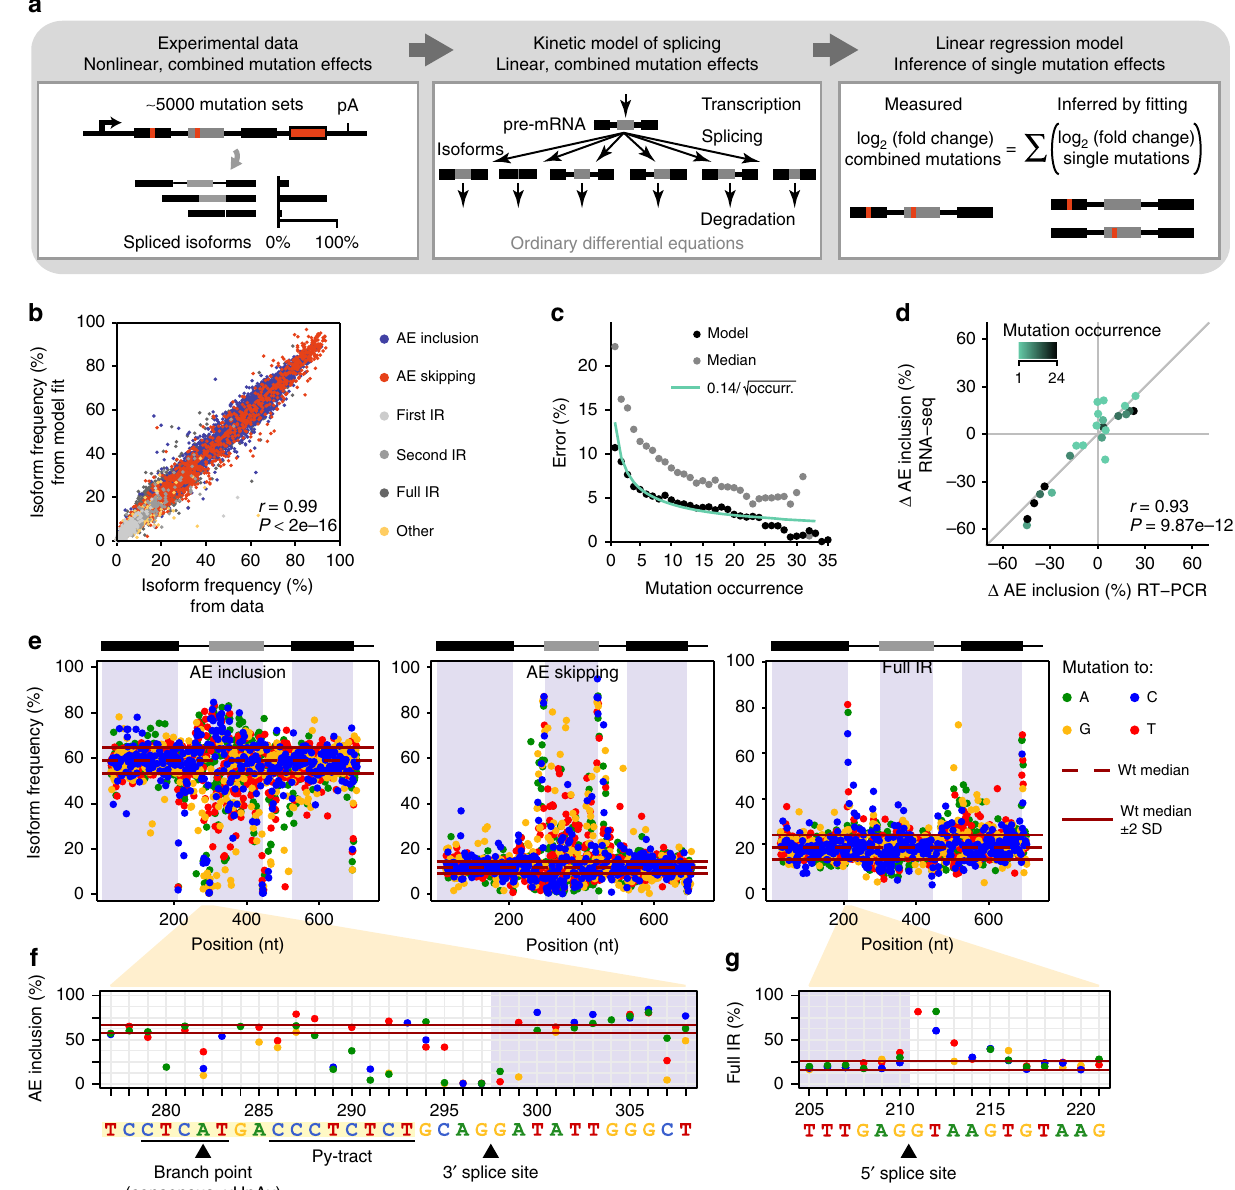
Fig. 2 A linear regression model determines more than 1900 single mutation effects. a Model-based inference of single mutation effects. Isoform quanti fi cations from RNA-seq for 5598 unique minigene variants, each harbouring multiple mutations, are used as input. A kinetic model of splicing reactions reveals that splice isoform ratios show linear mutation effects, irrespective of other mutations. A linear regression model is used to infer single mutation effects in a system of 5010 linear equations, one per mutated minigene variant. b Regression model describes experimental measurements with high correlation (Pearson correlation coef fi cient r = 0.99, P value <2e − 16). Scatterplot shows frequencies of distinct splice isoforms (see legend; separately shown in Supplementary Fig. 5a) for combined mutations calculated from fi tted model against one biological replicate (see Supplementary Note 2). c The model more accurately infers frequently occurring single mutation effects. Cross-validation by separately excluding single-mutation minigenes (and permutations of other minigenes containing this mutation). Inference is expressed as standard deviation of inference error in AE inclusion ( y -axis) and analysed for different permutations containing mutation at different frequencies ( x -axis). Inference power of model (black dots) matches theoretical expectation (green line) and outperforms median-based estimation (grey dots; see Supplementary Note 2). d Experimental validation of model- inferred single mutation effects. Semiquantitative RT-PCR measurements of AE inclusion (other isoforms in Supplementary Fig. 4b) for targeted single- mutation minigenes that were not used for model fi tting. Discrepancies between model and data appear if mutation infrequently occurs in the library (colour-coded). r , Pearson correlation coef fi cient and associated P value. e Model-inferred landscapes of 1747 single mutation effects on AE inclusion, AE skipping and full IR in HEK293T cells. Each mutation effect is indicated as a coloured dot (inserted nucleobase, see legend). Red lines indicate median (dashed) ± 2 standard deviations (SD; solid) for wt minigenes. f , g Zoom-in landscapes of single mutation effects on AE inclusion around 3 ′ splice site of RON exon 11 ( f ) and on full IR around 5 ′ splice site of constitutive exon 10 ( g ). Black lines and arrowheads mark splicing signals, including branch point, polypyrimindine tract (Py-tract) and splice sites. Visualisation as in